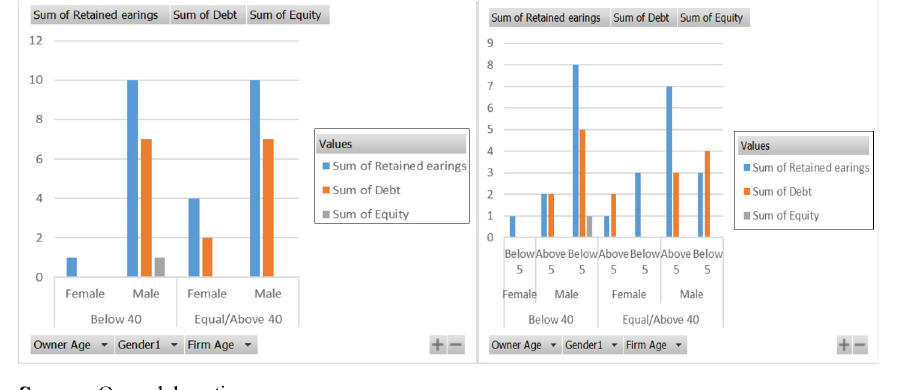
Figure 1. Financing